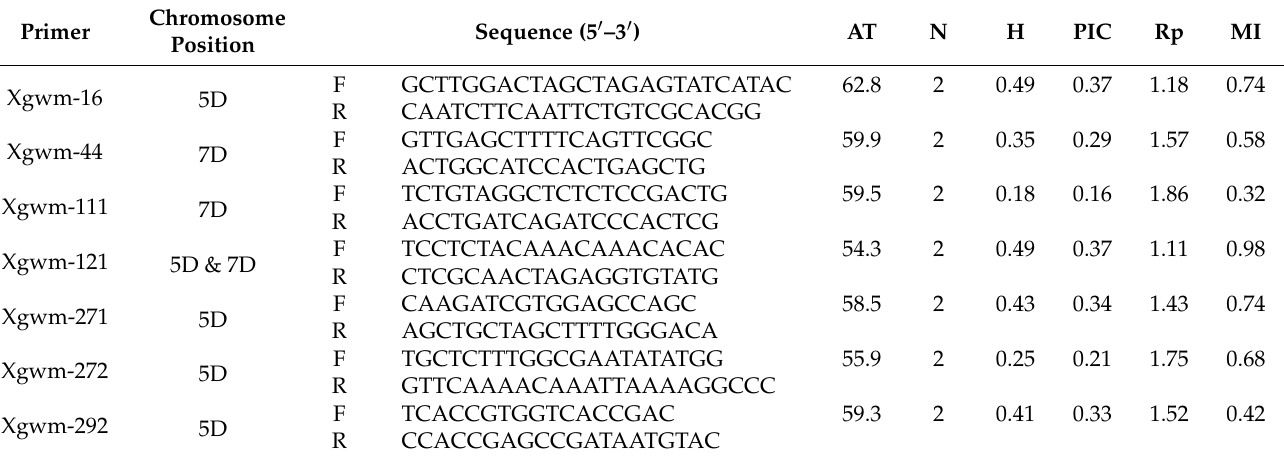
Table 3. Detailed information about the used SSR primers along with the results of estimated informativeness parameters for each of them.